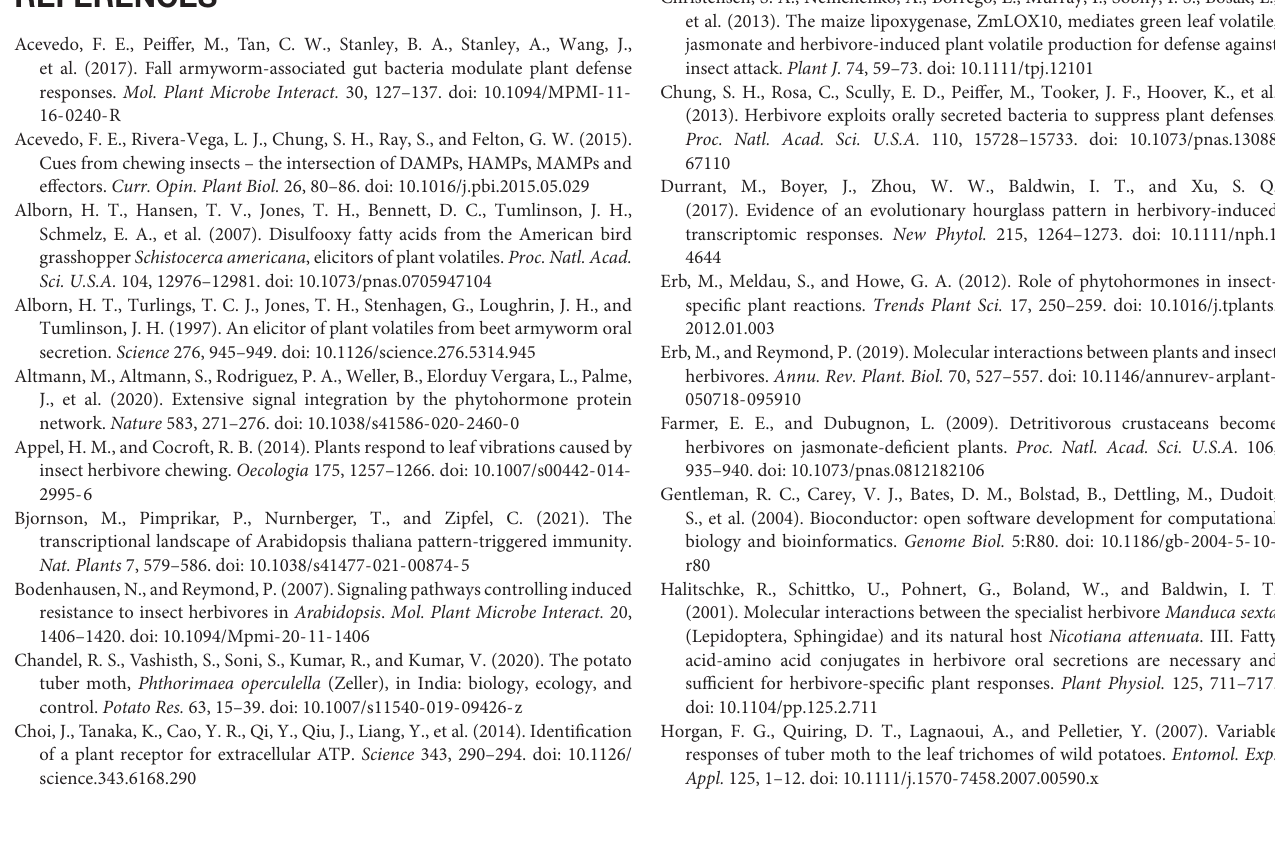
overrepresentation analysis is mapped to node size; Jaccard similarity between two GO terms is mapped to edge width; gene module is mapped to node color.